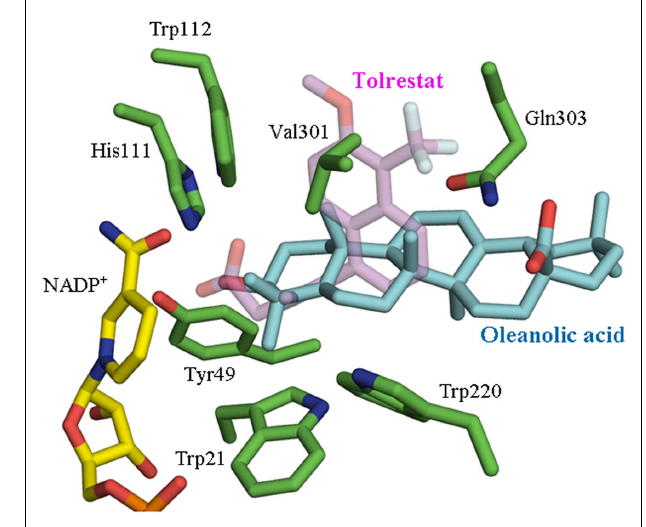
FIGURE 8 | Comparison of binding modes of oleanolic acid and tolrestat in theAKR1B10–NADP + complex. The oleanolic acid-docked model (Takemura et al., 2011) is superimposed on the crystal structure of tolrestat–NADP + –AKR1B10 ternary complex (Gallego et al., 2007), and only tolrestat (pink) is shown with residues involving in the binding to oleanolic acid